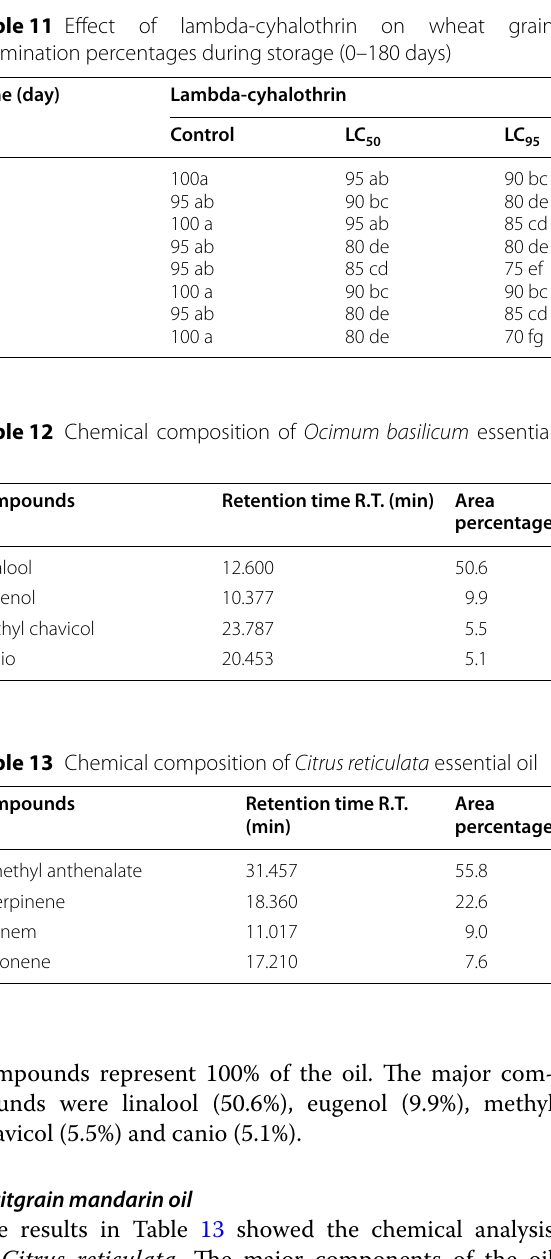
showed more toxicity at 48 h exposure against adults Table 11 Effect of lambda‑cyhalothrin on wheat grain